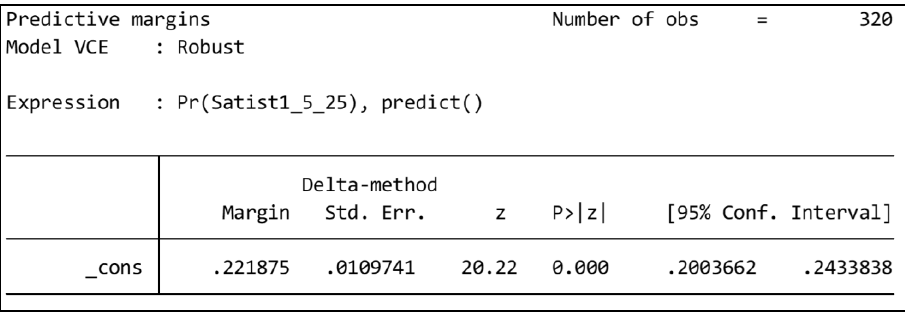
Figure 3. Predictive Margins Model 2.